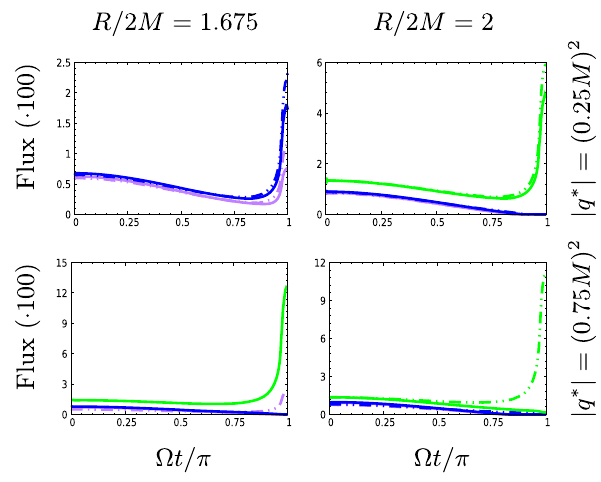
Fig. 7 Same configuration as in Fig.6 but for h = 0. We see that, for a constant plasma density, low frequencies do not satisfy the propagation conditions in the vicinity of the star